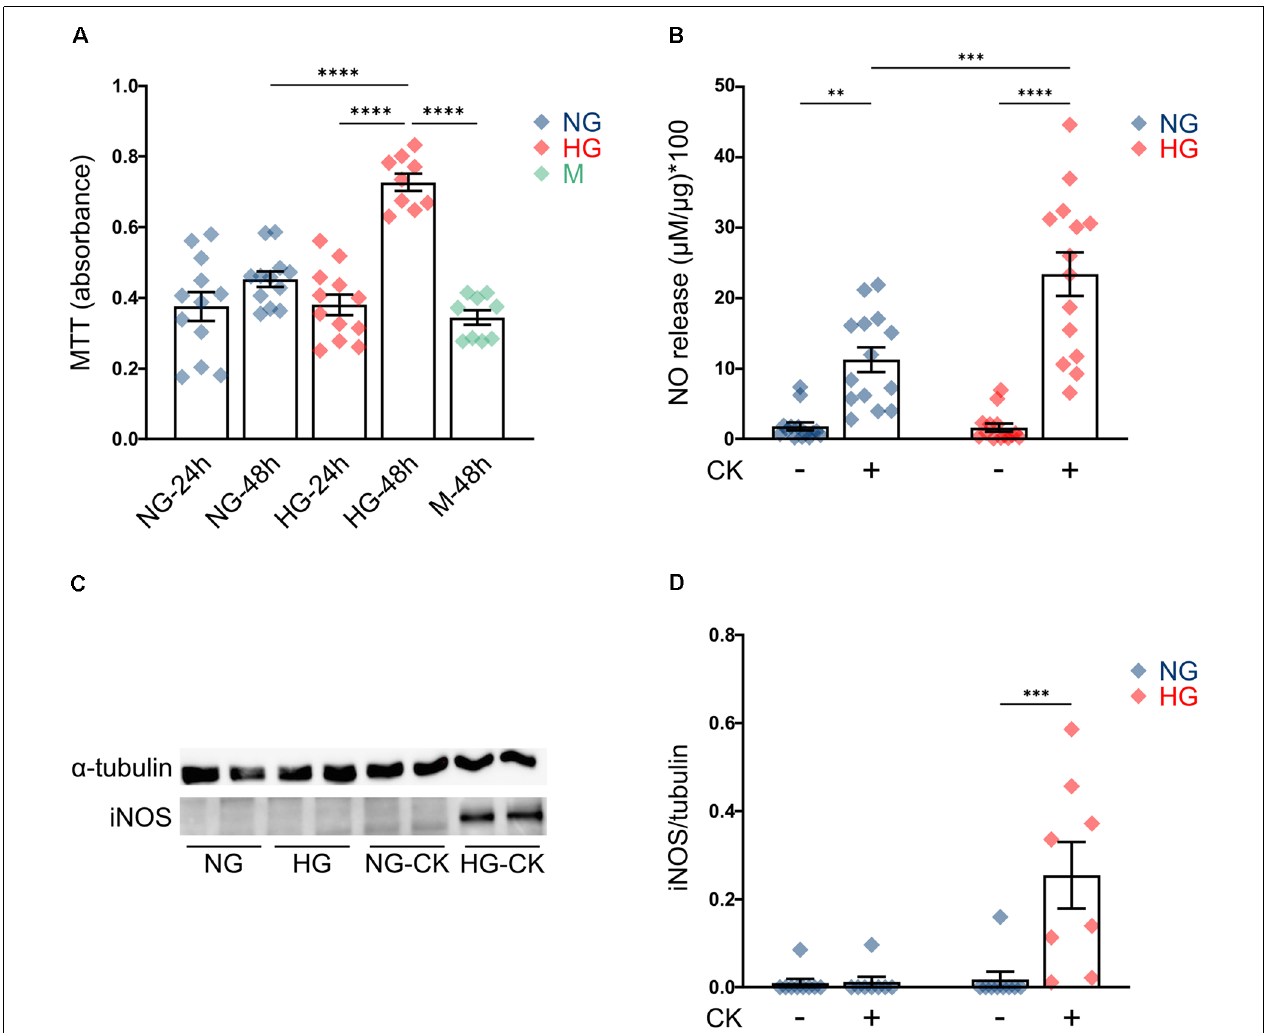
FIGURE 1 | Effect of high glucose (HG) on rMC-1 cellular proliferation and cytokine-induced activation. (A) Scatter graph with bars represents the proliferation rate of rMC-1 cells, plated at a density of 60,000 cells/well and examined after 24 or 48 h. HG promoted rMC-1 cellular proliferation at 48 h, but not at 24 h. Absorbance values of MTT [3-(4,5-dimethylthiazol-2-yl)-2,5-diphenyltetrazolium bromide] are expressed as mean ± SEM of four independent experiments. Statistical significance is calculated by two-way ANOVA followed by Tukey’s post-hoc test ( ∗∗∗∗ p < 0.0001). (B) Scatter graph with bars represents nitric oxide (NO) release from rMC-1 cells, indicative of cellular activation. rMC-1 cells were plated and maintained in culture for 24 h, then treated for 24 h with a cytokine mix (IL-1 β , TNF- α , and IFN- γ ). 48 h after plating, rMC-1 cells were lysed, and NO concentration was normalized over their total protein content. Absorbance values are expressed as mean ± SEM of five independent experiments. Statistical significance is calculated by two-way ANOVA followed by Tukey’s post-hoc test ( ∗∗ p < 0.005; ∗∗∗ p < 0.001; ∗∗∗∗ p < 0.0001). (C) Representative western blot image of inducible NO synthase (iNOS) expression of rMC-1 cells. iNOS is detectable only in HG-maintained rMC-1 cells treated with the cytokine mix. (D) Scatter graph with bars representing iNOS expression of untreated and CK-treated rMC-1 cells normalized over α -tubulin expression. Fold values are expressed as mean ± SEM of five independent experiments. Statistical significance is calculated by two-way ANOVA followed by Tukey’s post-hoc test ( ∗∗∗ p < 0.001). NG, normal glucose; HG, high glucose; M, mannitol; CK,